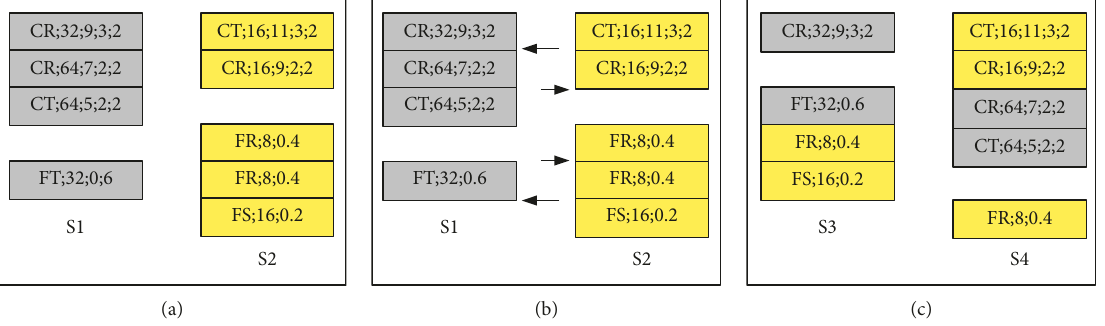
Figure 2: Crossover example: solutions S3 and S4 are produced from crossover of parents S1 and S2.